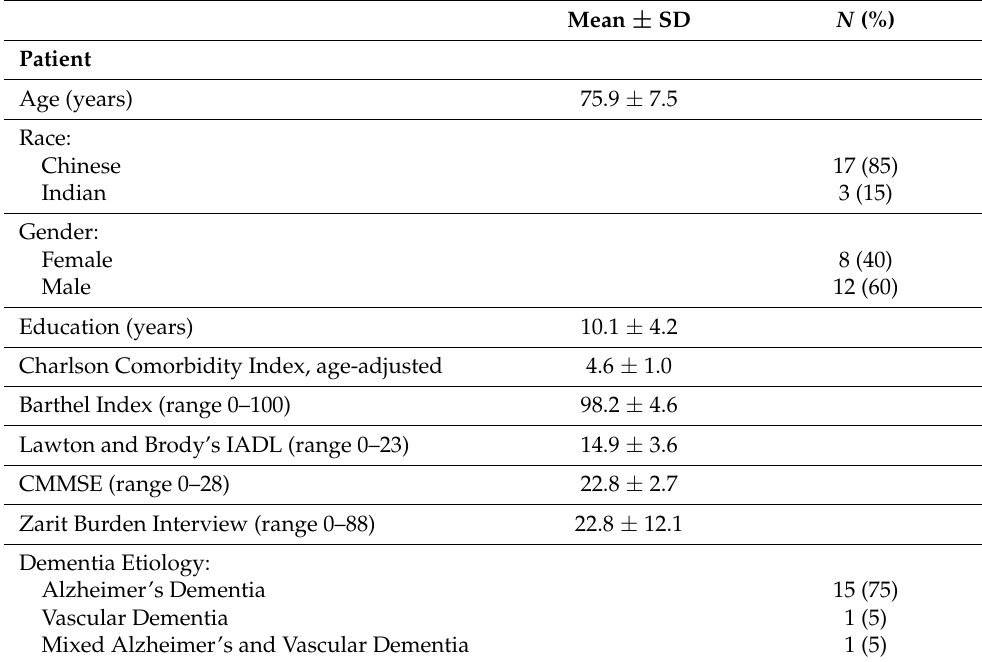
Table 1. Characteristics of the patient–caregiver dyads who underwent ACP counseling ( N =